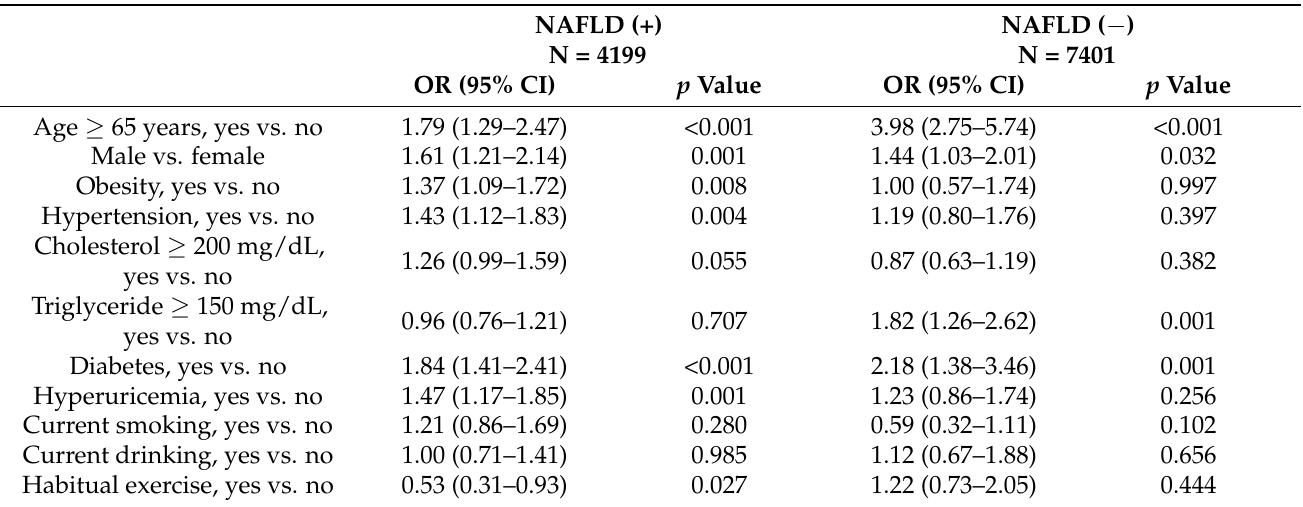
Table 3. Binomial logistic regression of the relationship between clinical variables and significant liver fibrosis in subjects with and without